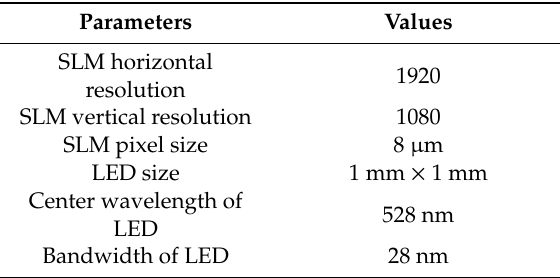
Table 1. Optical parameters in the experiment.